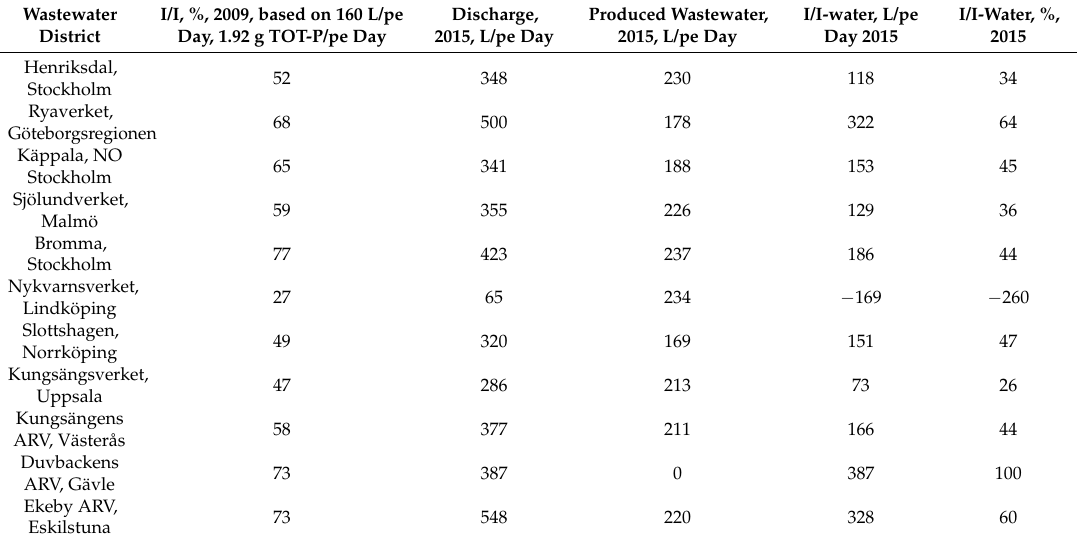
Table 10. Calculation of I/I-water for some big Swedish wastewater plants for 2009 and 2015 based on values of discharge and specific values of produced wastewater.